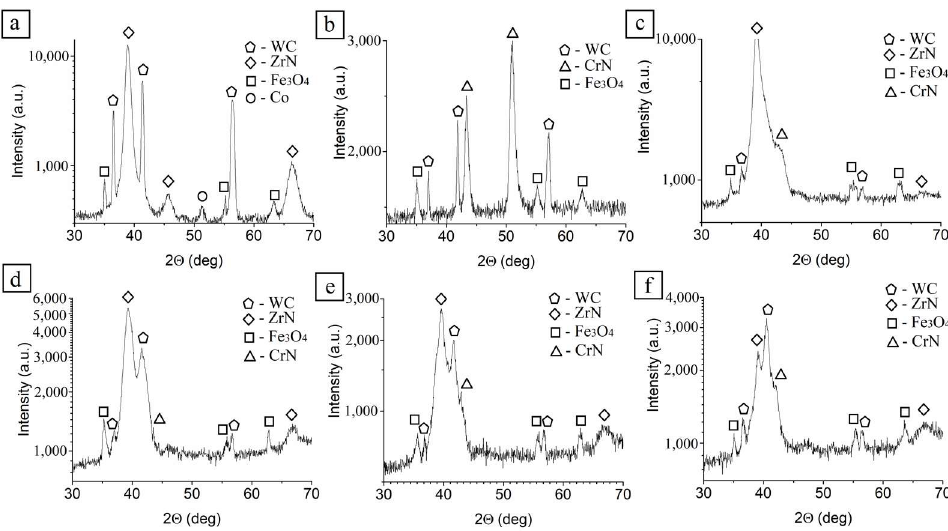
Figure 15. X-ray diffractograms obtained from the worn surfaces of coatings rubbed against the steel balls at 6N. Samples: ZrN ( a ), CrN ( b ), ZrCrN(0.5) ( c ), ZrCrN(3.5) ( d ), ZrCrN(5) ( e ) and ZrCrN(8) ( f ).